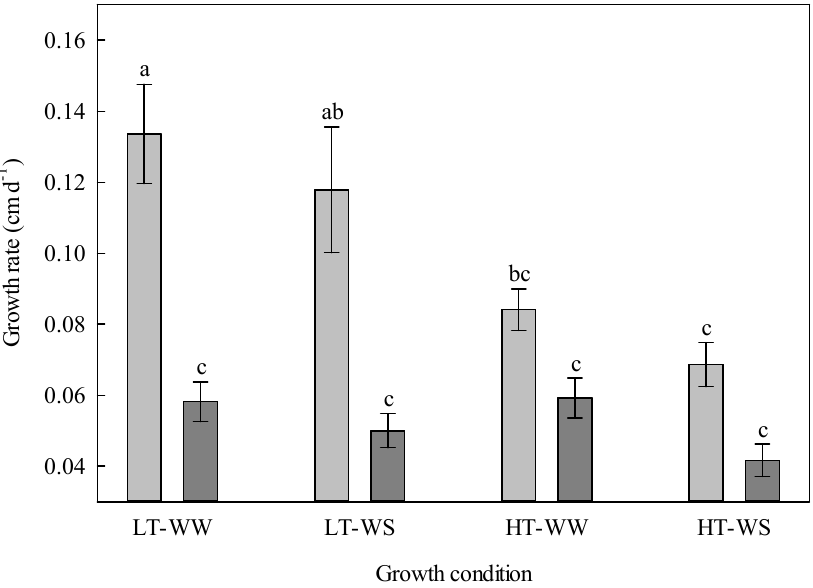
Figure 2. Growth rate of 33-day-old tomato plants grown under eight experimental conditions including two temperature regimes, two watering regimes, and two abscisic acid concentration applications after 12 days of initial germination and growth in growth chambers with lower temperature, watering to field capacity, and without abscisic acid application. LT, lower temperature; HT, higher temperature; WW, well-watered; WS, water stressed; light gray, no abscisic acid; dark gray, abscisic acid. Data are the means ± SE of 236 samples from three experiments. Bars with different letters above them are significantly different, according to Scheff é ’s multiple comparison procedure at the 5% confidence level.